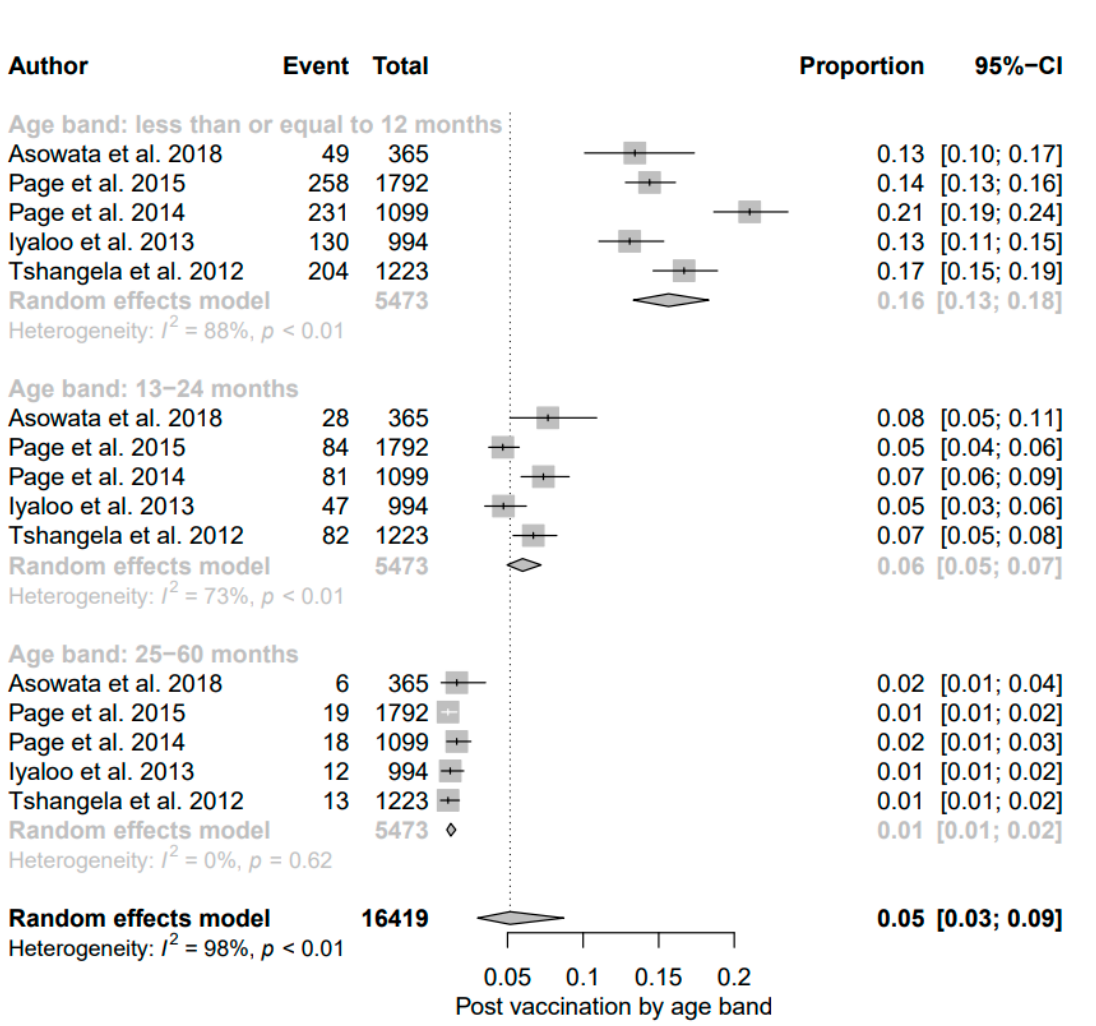
Figure 7. Subgroup analysis of rotavirus prevalence during post-vaccination era according to age